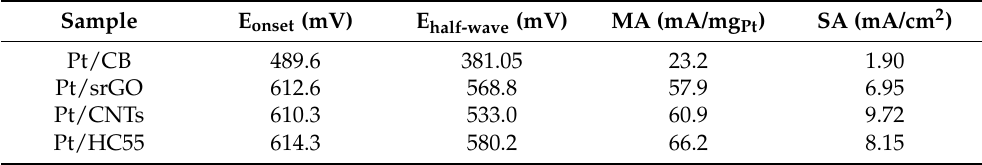
Table 2. E onset , E half-wave , MA, and SA values of Pt/CB, Pt/srGO, Pt/CNTs, and Pt/HC55.